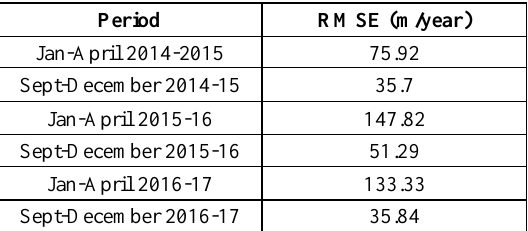
Table 2 . Seasonal changes